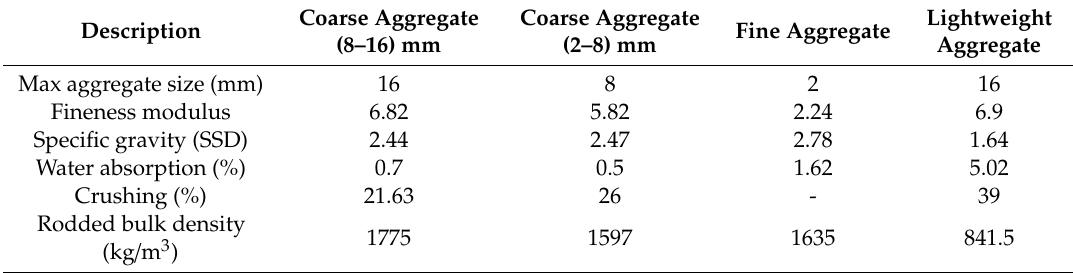
Table 1. Physical properties of fine and coarse